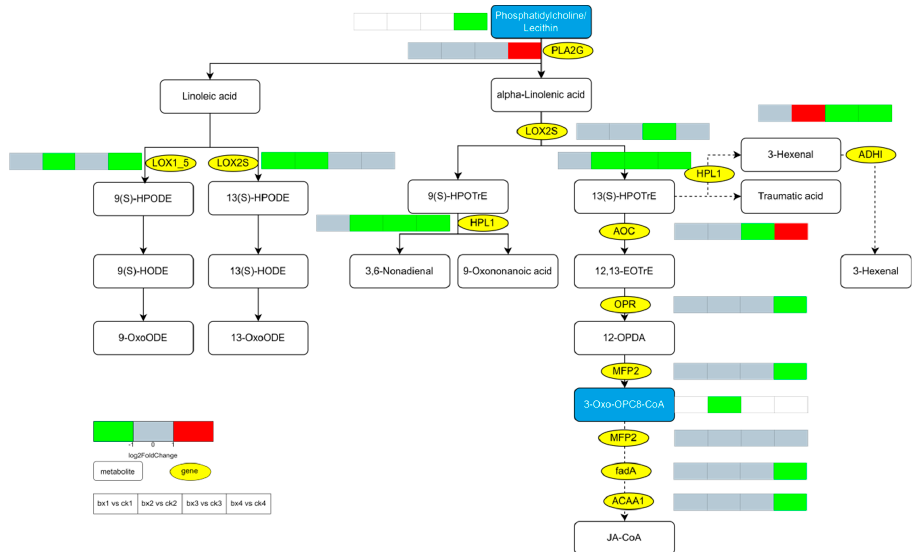
Figure 12. Expression profiles of genes and metabolites involved in linoleic acid metabolism and alpha-linolenic acid metabolism. The yellow oval pattern represents the gene and rounded rectangles represent metabolites. Metabolites in blue box were annotated and metabolites in white font were annotated. Four continuous boxes indicate the di ff erent fold changes of DEGs or DMs in bx1 vs. ck1; bx2 vs. ck2; bx3 vs. ck3; and bx4 vs. ck4, respectively. Red indicates up-regulated (log2foldchange > 1), green indicates down-regulated (log2foldchange < − 1), grey indicates no signi fi cant change ( − 1 ≤ log2foldchange ≤ 1) and white indicates the metabolites or genes that were not annotated. PLA2G, Phospholipase A2 Group; HPL1, hydroperoxide lyase l; LOX, lipoxygenase; ADH, alcohol dehydrogenase; AOC, allene oxide cyclase; OPR, 12-oxo-phytodienoic acid reductase; MFP2, enoyl-CoA hydratase/3-hydroxyacyl-CoA dehydrogenase ; ACAA1, acetyl-CoA acyltransferase 1. 4. Discussion Appearance and texture are two fundamental factors that determine the acceptability of FFV [22]. Browning and softening during post-harvest storage cause the appearance quality of Lanzhou lily bulbs to decline, thus a ff ecting consumers’ acceptability and purchasing power. Mechanical damage (fresh cu tt ing) triggers increased respiratory rate and ethylene production in plant tissues [23], destruction of membrane integrity [24] and a large number of physiological and biochemical reactions such as the biosynthesis of secondary metabolites [25]. The integrity of the cell membrane is one of the key factors a ff ecting the browning of fruits and vegetables, mechanical-damage-enhanced membrane lipid peroxidation and lost membrane integrity [26]. Lipids are the basic components of cell membranes. The escape of phenolic substances produces a browning of the tissues under the pro-browning action of Polyphenol oxidase (PPO) [27]. Studies show that linolenic acid and linoleic acid play important roles in fruit browning [28], especially in reducing the proportion of unsaturated fa tt y acids, which result in the browning of fruits and vegetables [29]. A delayed reduction in linoleic acid and linoleic acid content and increased proportion of unsaturated fa tt y acid/saturated fa tt y acid in the fruit can help reduce browning inside the fruit [30,31]. Transcriptomics and metabolomics data showed that key enzymes for the synthesis of linolenic acid and linoleic acid, Phospholipase A2 Group (PLA2G), were up- regulated later in MAP . Linolenic acid and linoleic acid are the main substrates of Lipoxygenase (LOX), so when the activity of lipoxygenase LOX is low, and the metabolic pathway downstream of linolenic acid and linoleic acid metabolism is inhibited, high